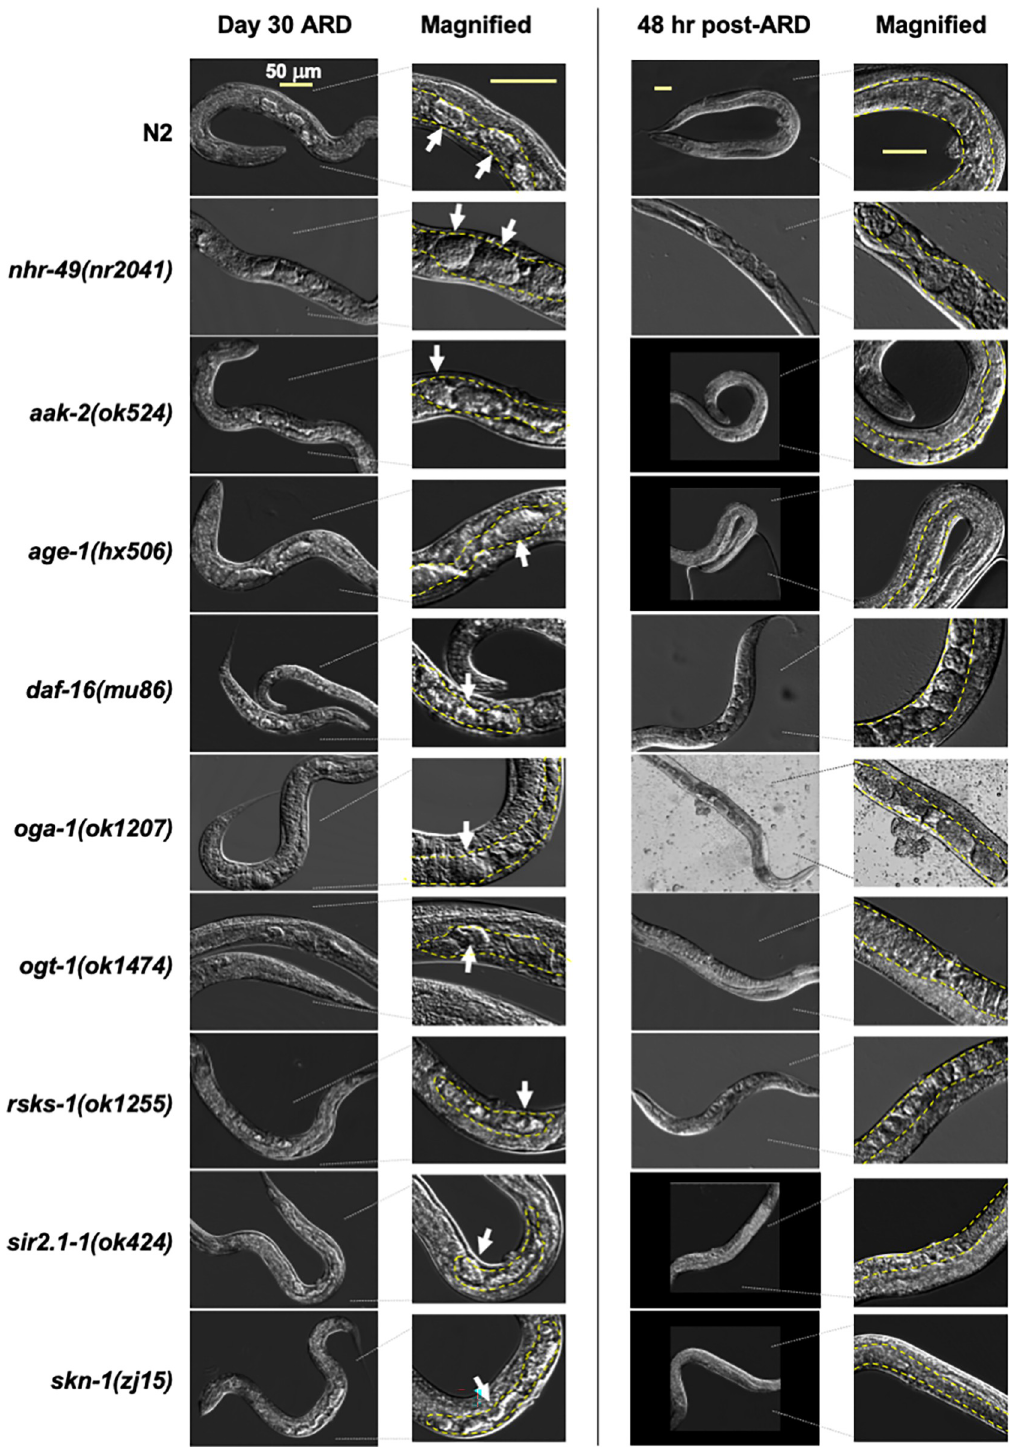
Fig 2. Germline shrinkage during ARD maintenance and regrowth during recovery. Representative images (with magnified panels for detail] showing the germline (outlined in yellow] of worms starved (left panel] at day 30 of ARD, with uterine embryos noted with white arrows. The right panel shows worms that have been re-feed for 48 hours after 30 days of ARD, with white dashed lines to indicate the germline, where healthy embryos and/or oocytes can be seen. All strains showed robust shrinkage of the germline during starvation and regrowth after feeding. The 50 μ m scale bar shown in the top row applies to all images in each column. https://doi.org/10.1371/journal.pone.0274076.g002 PLOS ONE | https://doi.org/10.1371/journal.pone.0274076 September 16,